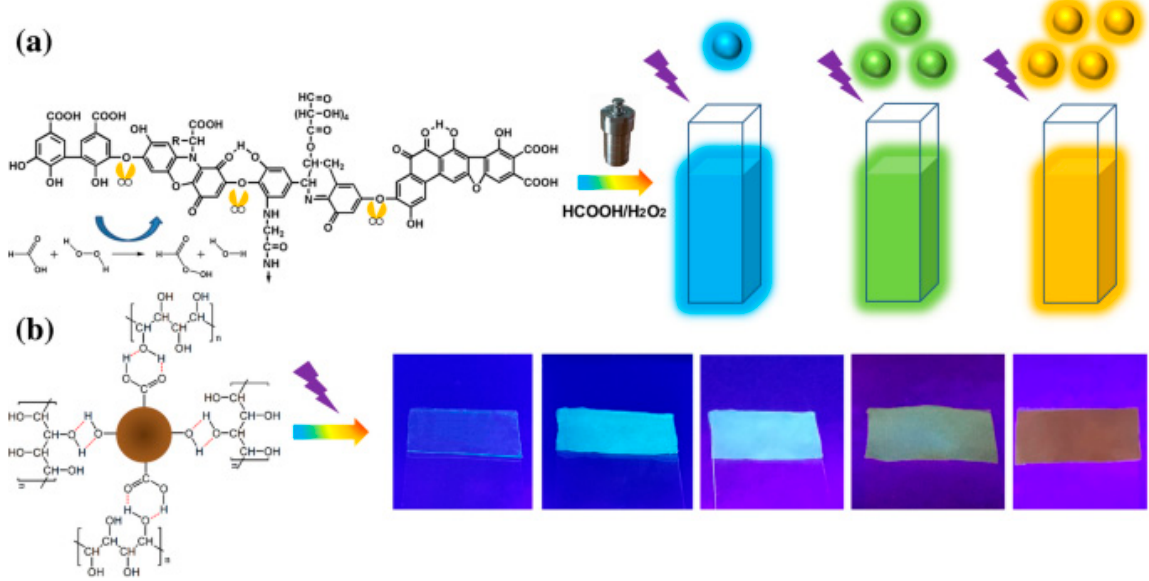
Figure 4. ( a ) The fabrication of CDs that exhibited concentration-dependent multicolor luminescence in deionized water, N,N-dimethylformamide, and formic acid ( b ) concentration-dependent multicolor CDs/PVA composite films exhibiting cyan, blue, and light-yellow emitting fluorescence (reprinted with permission from [105], 2022, Springer Nature).